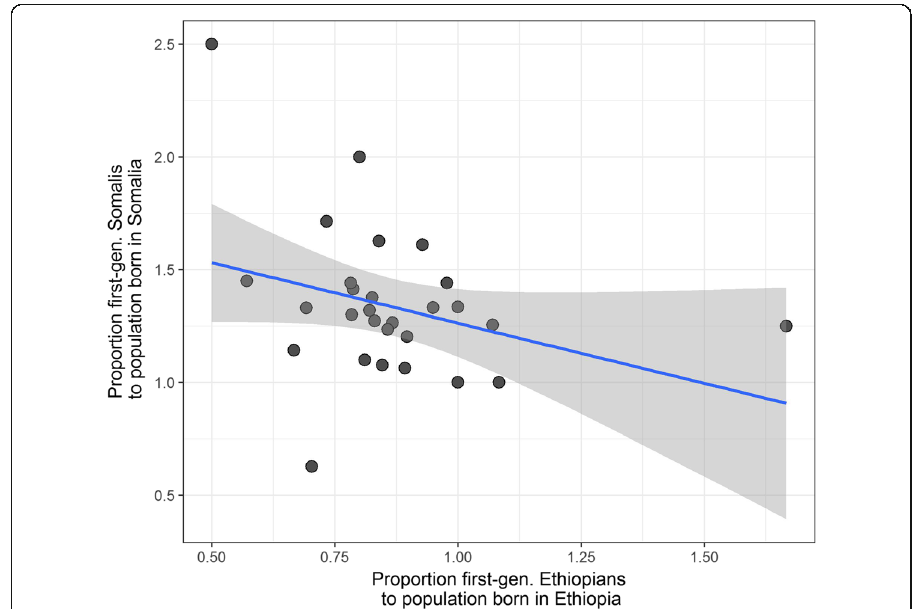
Fig. 7 Proportion of first-generation Somalis to population born in Somalia, plotted against proportion of first-generation Ethiopians to population born in Ethiopia for CMAs with populations of both groups. Blue line indicates linear regression trend and grey area is 95% confidence interval for the regression